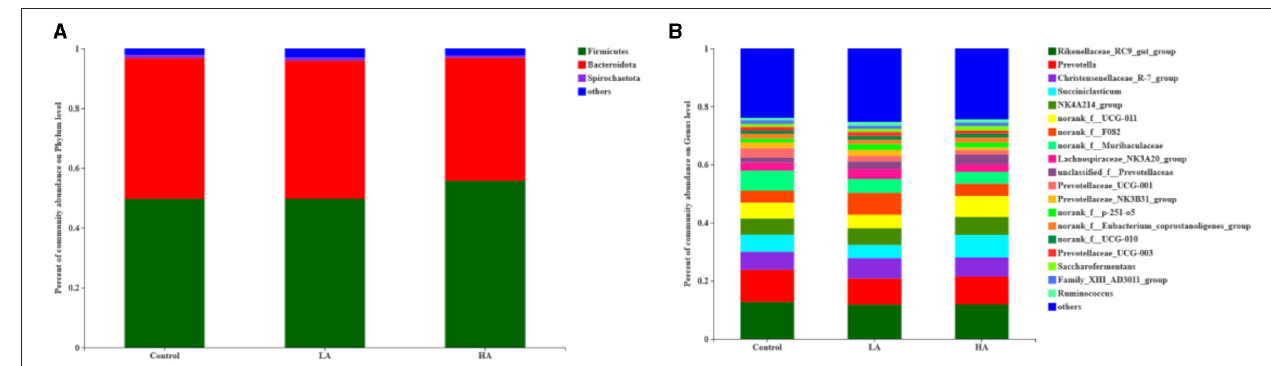
FIGURE 3 | Effect of anthocyanin-rich purple corn on rumen dominant bacteria ( > 1%; as a percentage of the total sequence). (A) Phylum level. (B) Genus level. LA = basal diet + 0.5-g/d PCP; HA = basal diet + 1-g/d PCP.